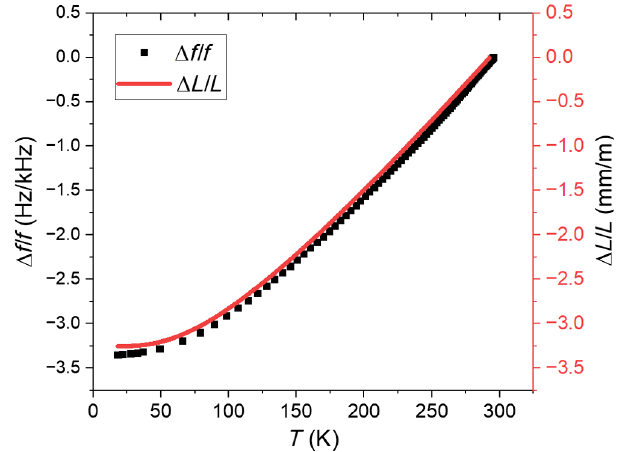
FIG. 15. Normalized shift in resonance frequency of the Cu = Nb = Nb 3 Sn cavity along with the normalized thermal ex- pansion of Cu as a function of